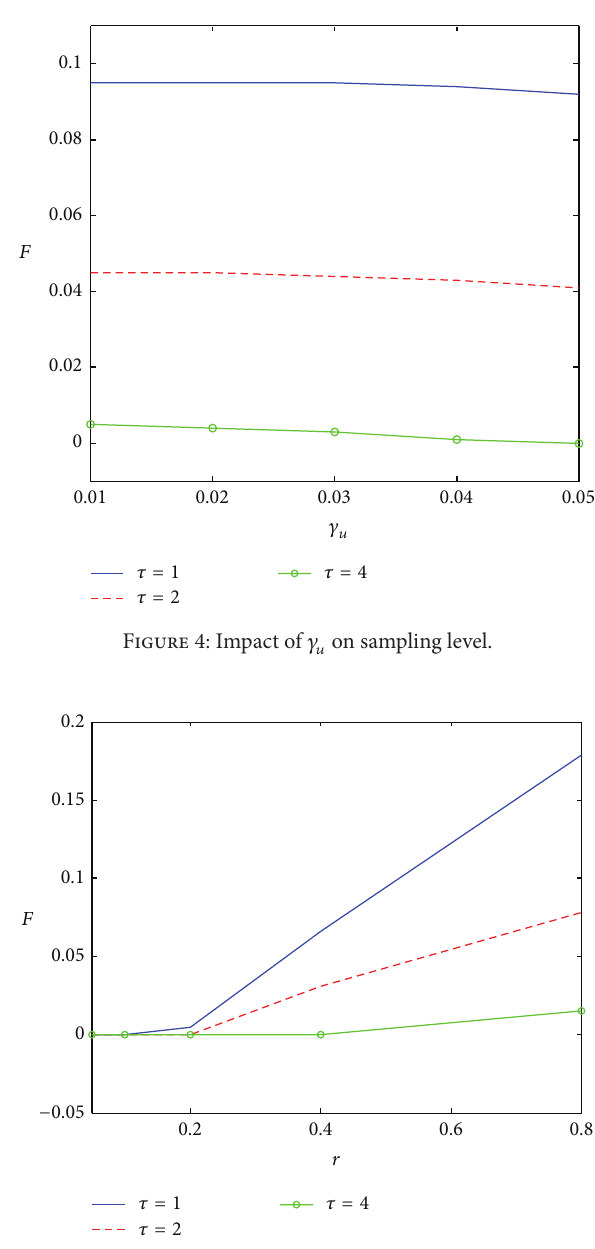
Figure 3: Impact of 𝑏 on sampling level.